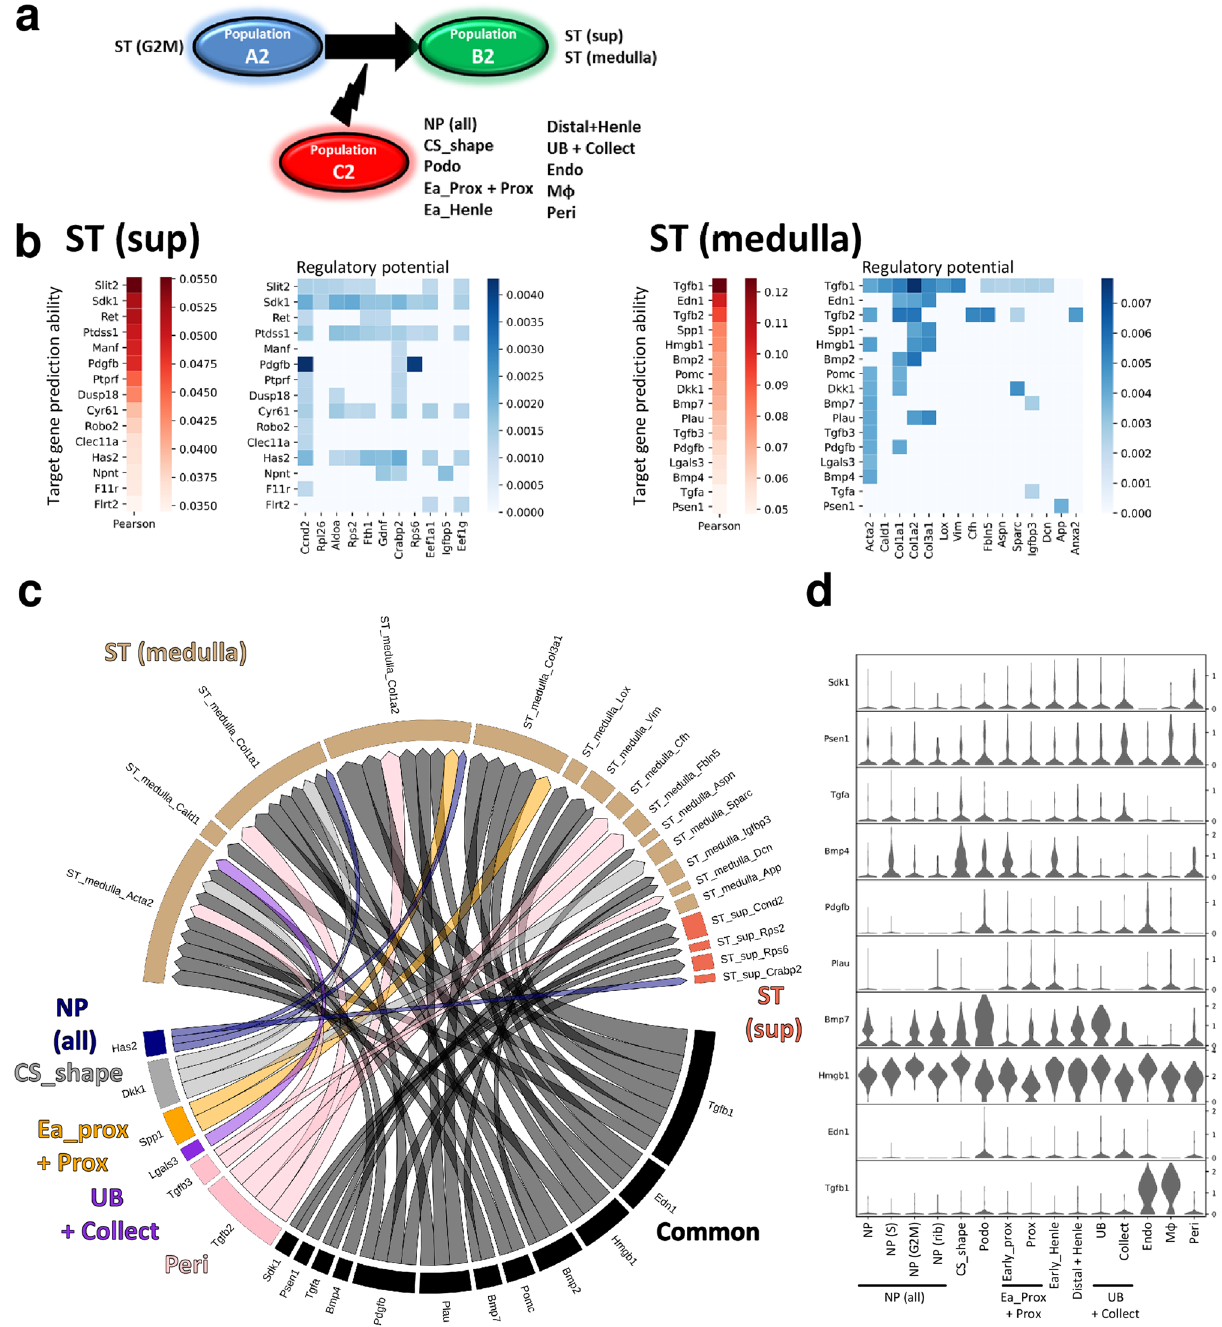
Figure 8. Intercellular communication in the development of stromal cells. ( a ) Intercellular communication in the development of stromal cells was inferred using NicheNet. The signals from the nephron progenitor (NP), S-phase NP (NP (S)), G2M-phase NP (NP (G2M)), ribosome-enriched NP (NP (ribo)), comma and S shaped bodies (CS_shape), podocyte (Podo), early phase proximal tubule (Early_prox), proximal tubule (Prox), early phase Henle (Early_Henle), distal tubules and the loop of Henle (Distal + Henle), ureteric bud (UB), collecting duct (Collect), endothelial (Endo), macrophage (Mφ), and pericyte (Peri) clusters that induced the superficial stroma (ST (sup)) and medullary ST (ST (medulla)) clusters from the G2M-phase ST (ST (G2M)) cluster were analyzed. Because many clusters were included in Population_C2, the NP, NP (ribo), NP (S), and NP (G2M) clusters were processed as one group, which was named NP (all). In a similar manner, the Early_prox and the Prox clusters were processed as one group, which was named Early_ prox + Prox. The UB cluster and the Collect clusters were also processed as one group, which was named UB + Collect. ( b ) Red heatmaps indicate the Pearson correlation. The blue heatmap denotes the regulatory potential between ligands expressed in Population_C2 and target genes expressed in Population_B2. ( c ) Results shown in ( b ) are summarized in a circos plot. ( d ) Stacked violin plot showing the origin of the common ligands in Fig. 8c. All data were analyzed using R version 3.6.3 (http://www.R-proje ct.org/) and NicheNet version 0.1.0 (https ://githu b.com/saeys lab/niche